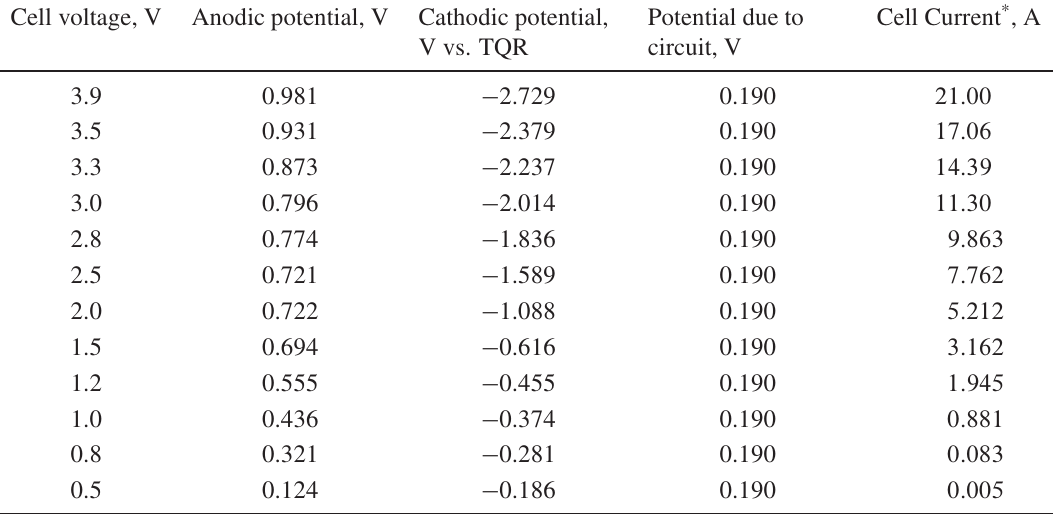
Table 5. Electrode potential and cell current at various levels of cell voltage as plotted also in Figure 1.